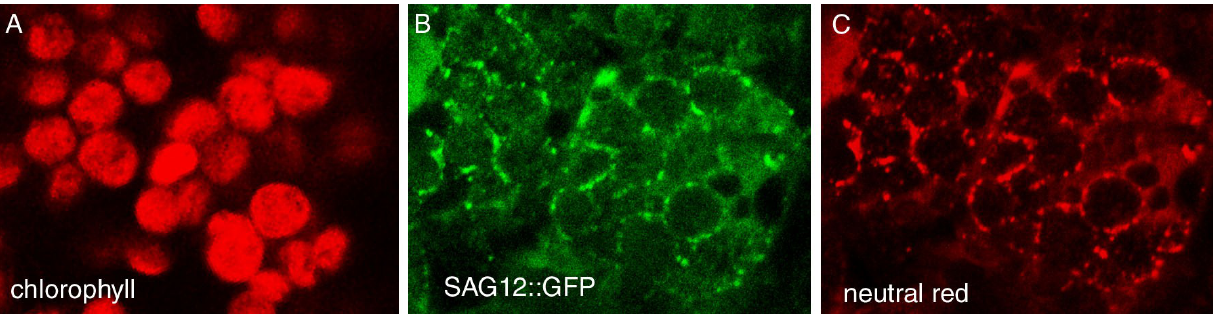
Figure 2. SAG12-GFP localization in senescing Arabidopsis leaves. Confocal images through the mesophyll of a senescing leaf from a SAG12-GFP transgenic plant incubated with the acidotropic dye Neutral Red. ( A ) Chlorophyll fluorescence (excitation 633 nm/emission > 650 nm), ( B ) SAG12-GFP (excitation 488 nm/ emission 505–550 nm), ( C ) Neutral Red (excitation 543 nm/emission 550–605 nm). Note that the GFP signal colocalizes with the fluorescence from Neutral Red, indicating that SAG12-GFP is located inside SAVs. Scale bar = 10 µm. Redrawn from